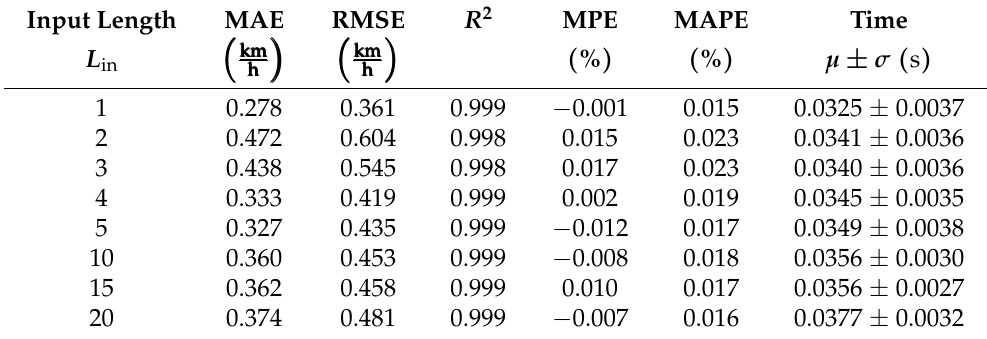
Table 3. Evaluation metrics for the TNN model when trained with input sequences of differ- ent